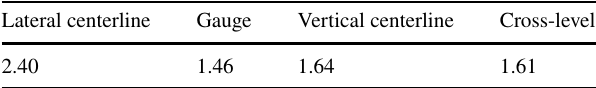
Fig. 2 The curv values plotted against the position values. The sec- tion of the track used for the simulations, i.e., the straight section, is marked. The last observation of the straight track is the 7554th obser- vation Table 2 Standard deviations of different types of track displacements (unit: mm), which are calculated from the straight track section of the provided data